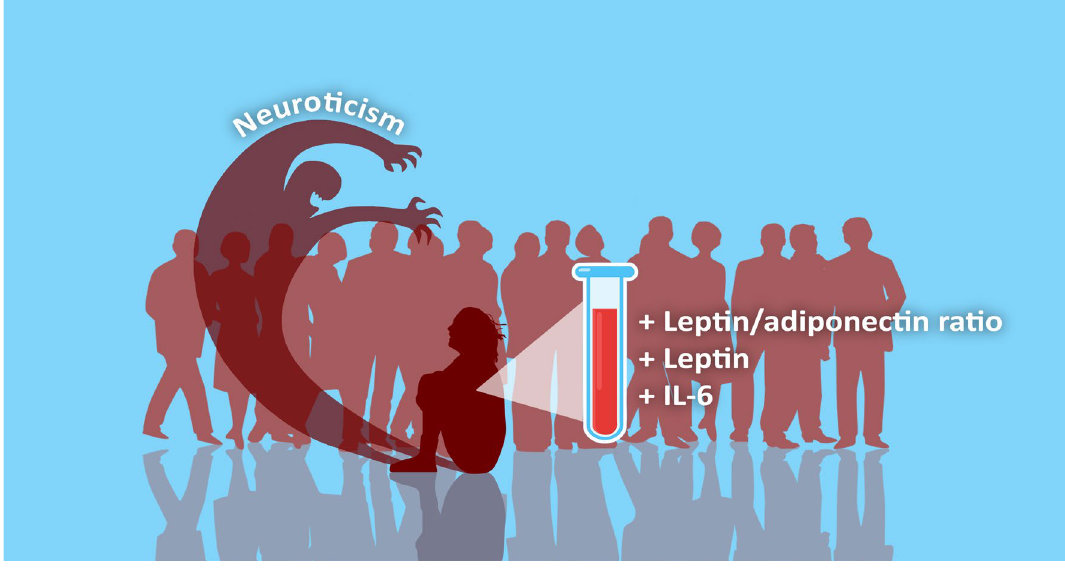
Figure 2. Graphical